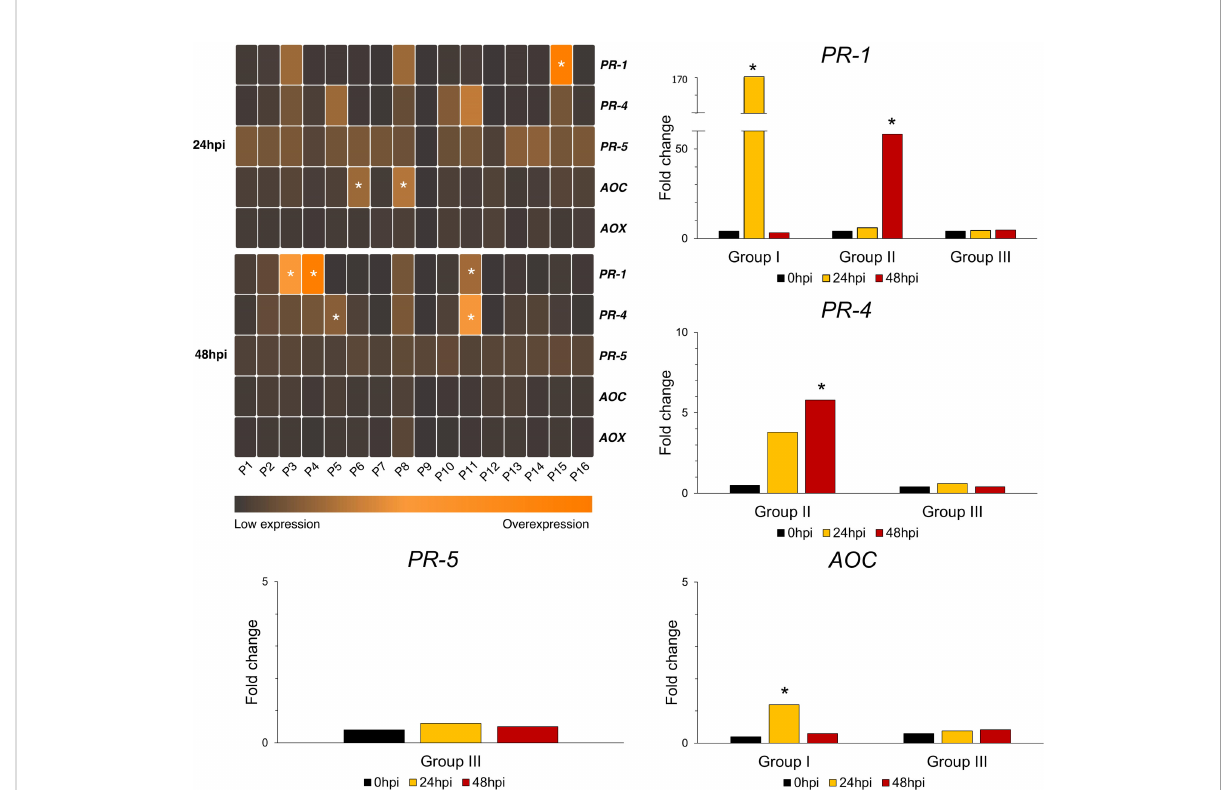
FIGURE 3 Differential expression heatmap of the genes involved in SA ( PR-1 , PR-5 ), JA ( PR-4 , AOC ) and Alternative Oxidase ( AOX ) pathways, relative to 0hpi. According to Tukey ’ s HSD ( a=0.05 ), genotypes of similar gene expression performance are arranged to the same group. For every different gene, the groups may consist of different accessions. In the heatmap, the colored cells indicate the presence of a group. The performance of the different groups is also depicted in histograms as log2 transformed expression levels. The asterisk (*) indicates statistically signi fi cant differences